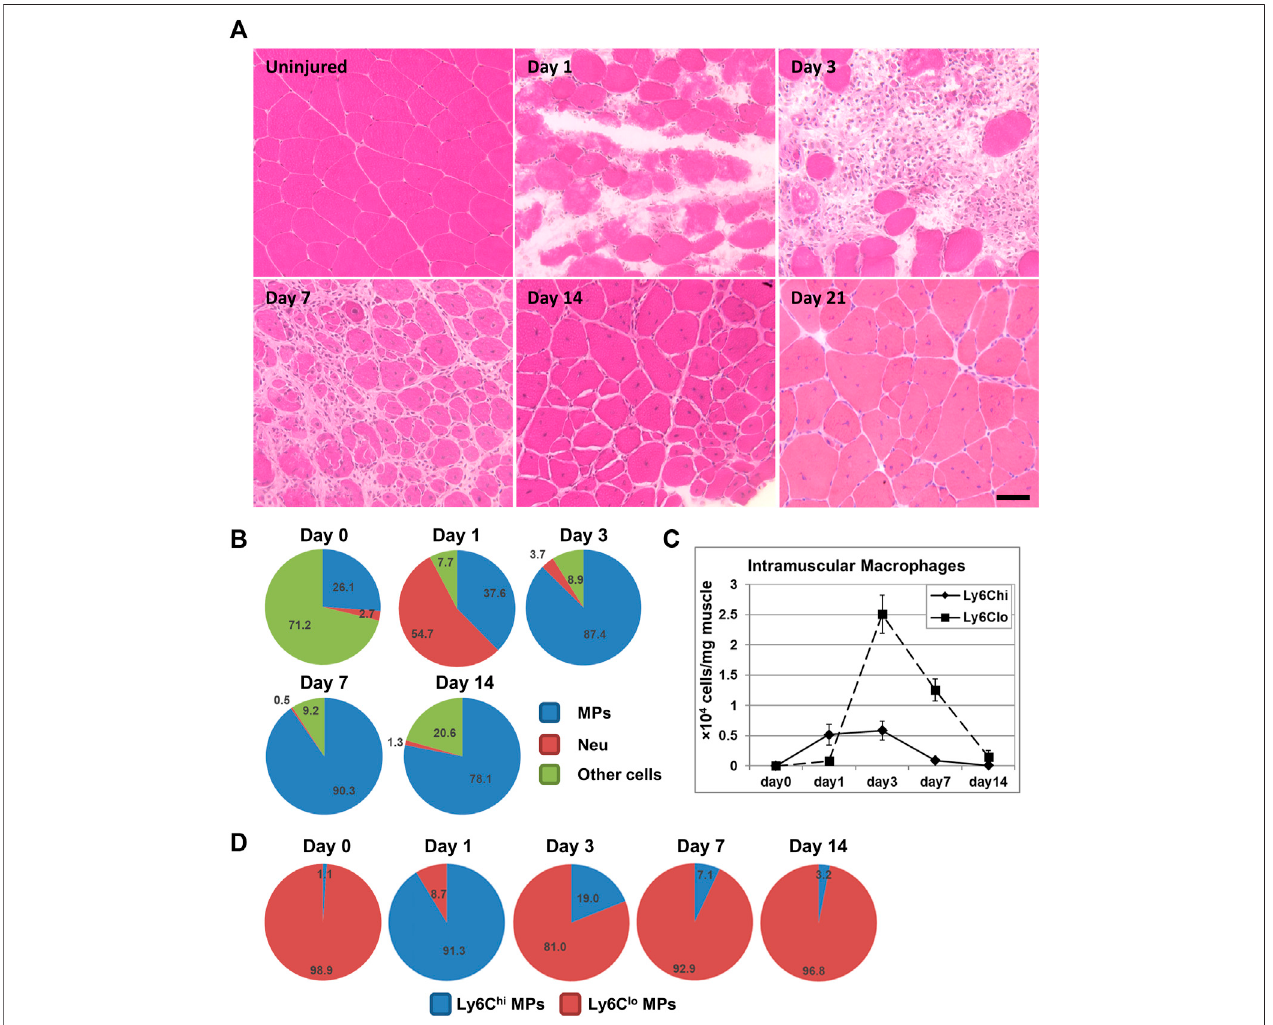
FIGURE1|(A) H&Estainingillustratingthenormal acutemuscleinjuryrepairprocessfollowingintramuscularBaCl 2 injectionintomousequadricepsmuscle.Bar= 50 μ m. (B) Pie chart showing percentages of macrophages (MPs), neutrophils (Neu), and other cells among CD45 + cells in BaCl 2 -injured quadriceps muscle at different days post injury. (C) Line graph showing densities of intramuscular Ly6C hi and Ly6C lo macrophages in BaCl 2 -injured quadriceps at different days post injury. (D) Pie charts showing percentages of Ly6C hi and Ly6C lo subpopulations among macrophages in BaCl 2 -injured quadriceps at different days post